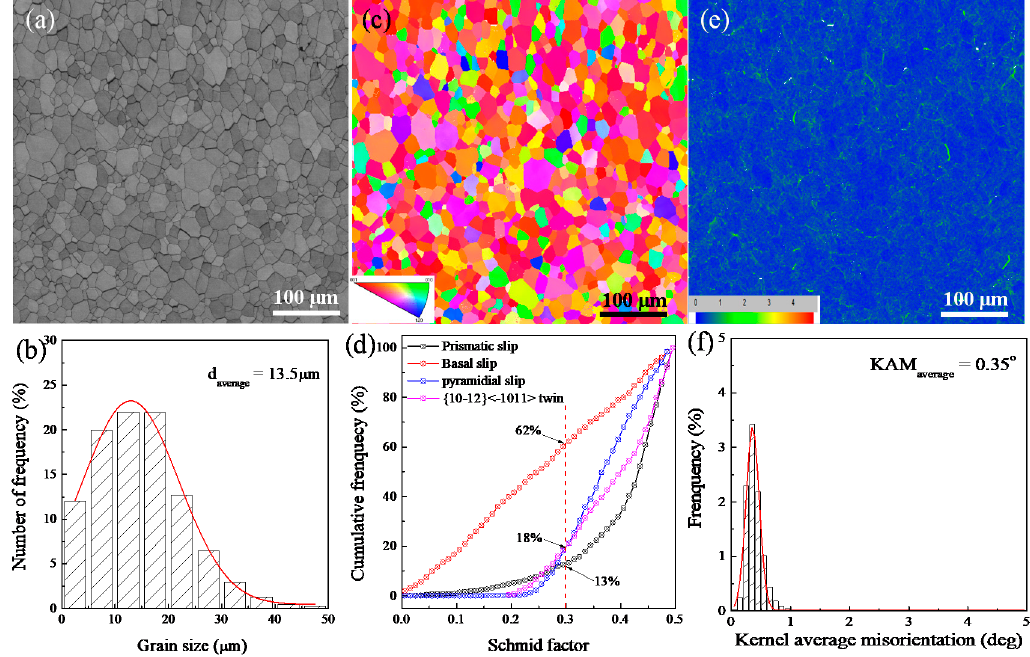
Figure 1. The initial microstructural characteristics of TA2: ( a , b ) BC map and the distribution of grain size; ( c , d ) IPF and cumulative frequency of SF for different deformation modes; and ( e , f ) KAM map and the frequency distribution of KAM.